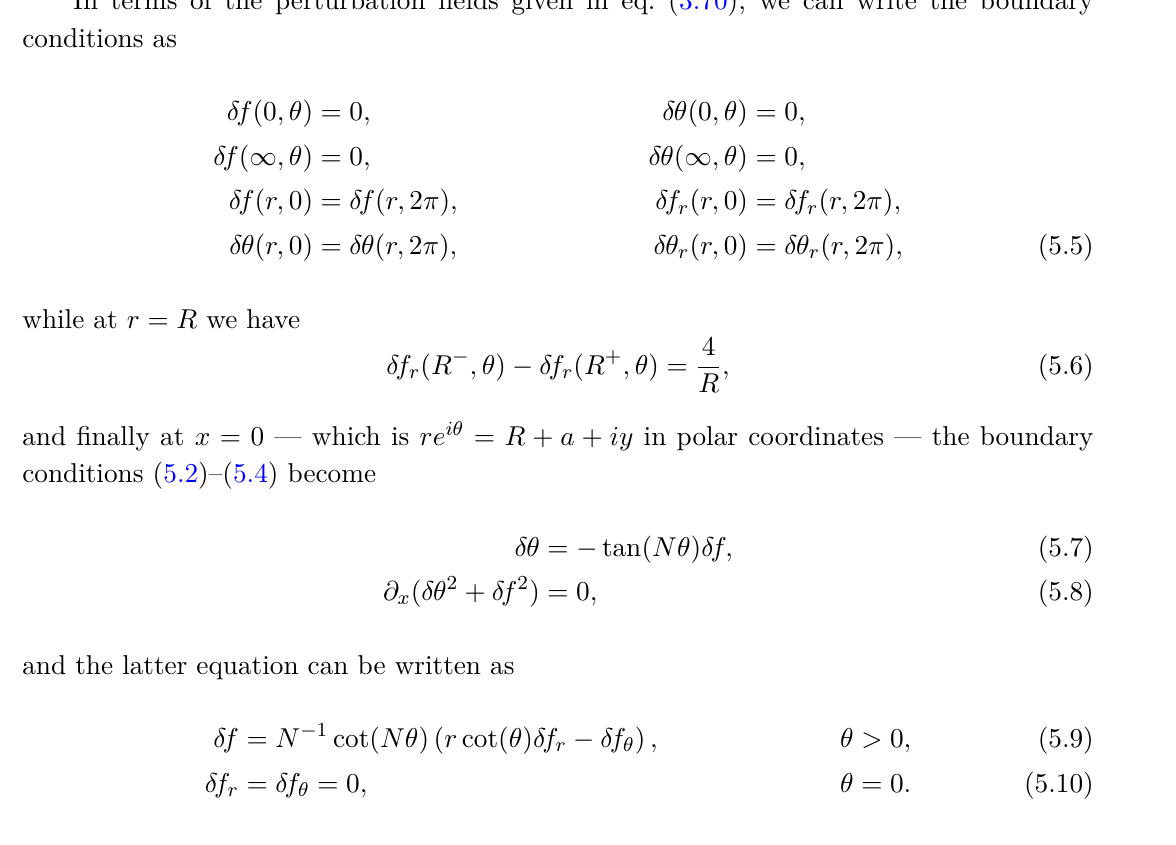
would make it an anti-Skyrmion) is to impose the boundary condition as given in the